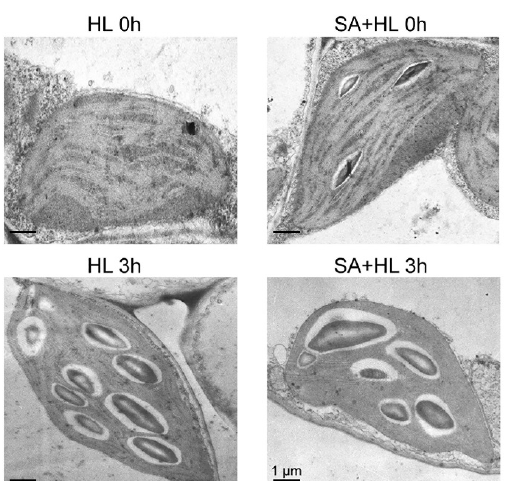
Figure 8. Transmission electron microscope analysis of chloroplasts in Arabidopsis thaliana under high light in the presence or absence of SA. HL 0 h, high light for 0 h without SA pretreatment. SA + HL 0 h, high light for 0 h with SA pretreatment. HL 3 h, high light for 3 h without SA pretreatment. SA + HL 3 h, high light for 3 h with SA pretreatment. Scale bar represents 1 μ m in each figure.